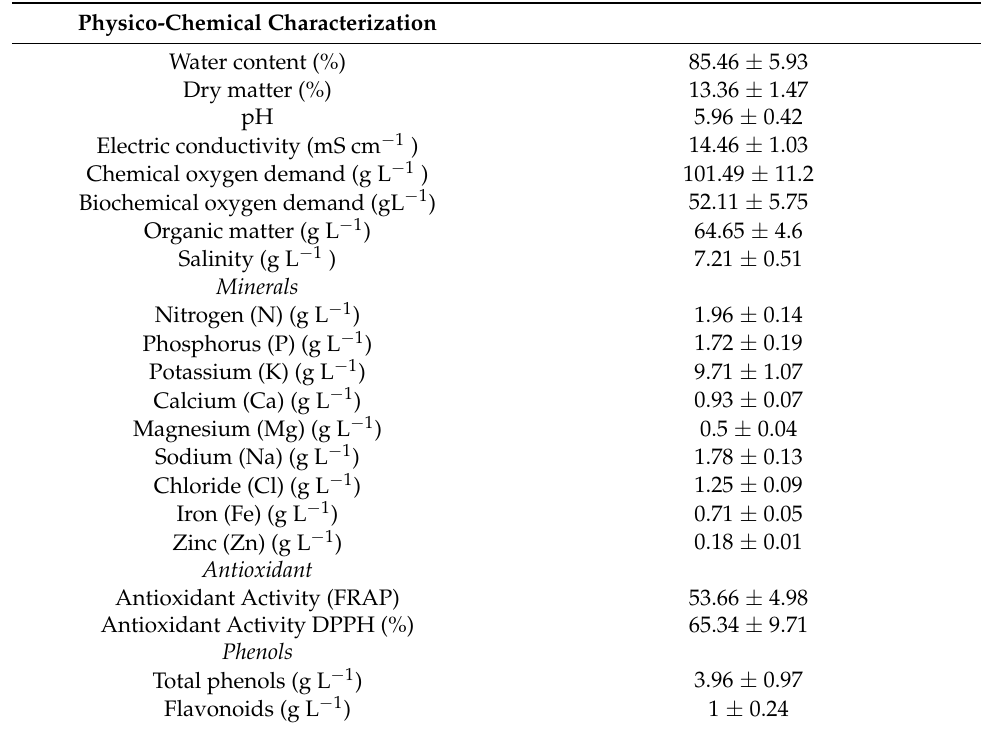
Table 3. Physico-chemical characterization of olive solid waste (OSW). Three sampels of OSW were analyzed. Values are presented as mean ±